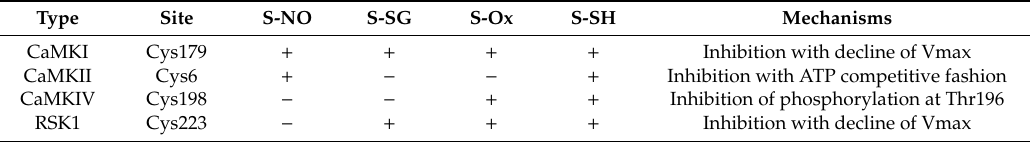
Table 1. The types of redox-sensitive Cys modification in protein